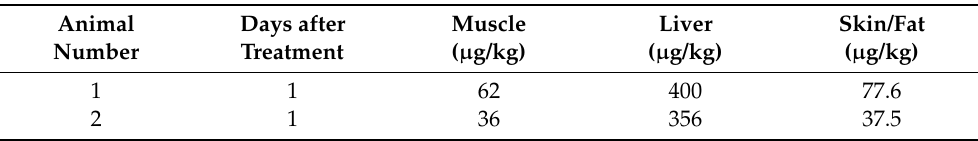
Table 5. Values found in turkeys for tiamulin marker residues (dose 20,000 µ g THF/kg body weight/day 7